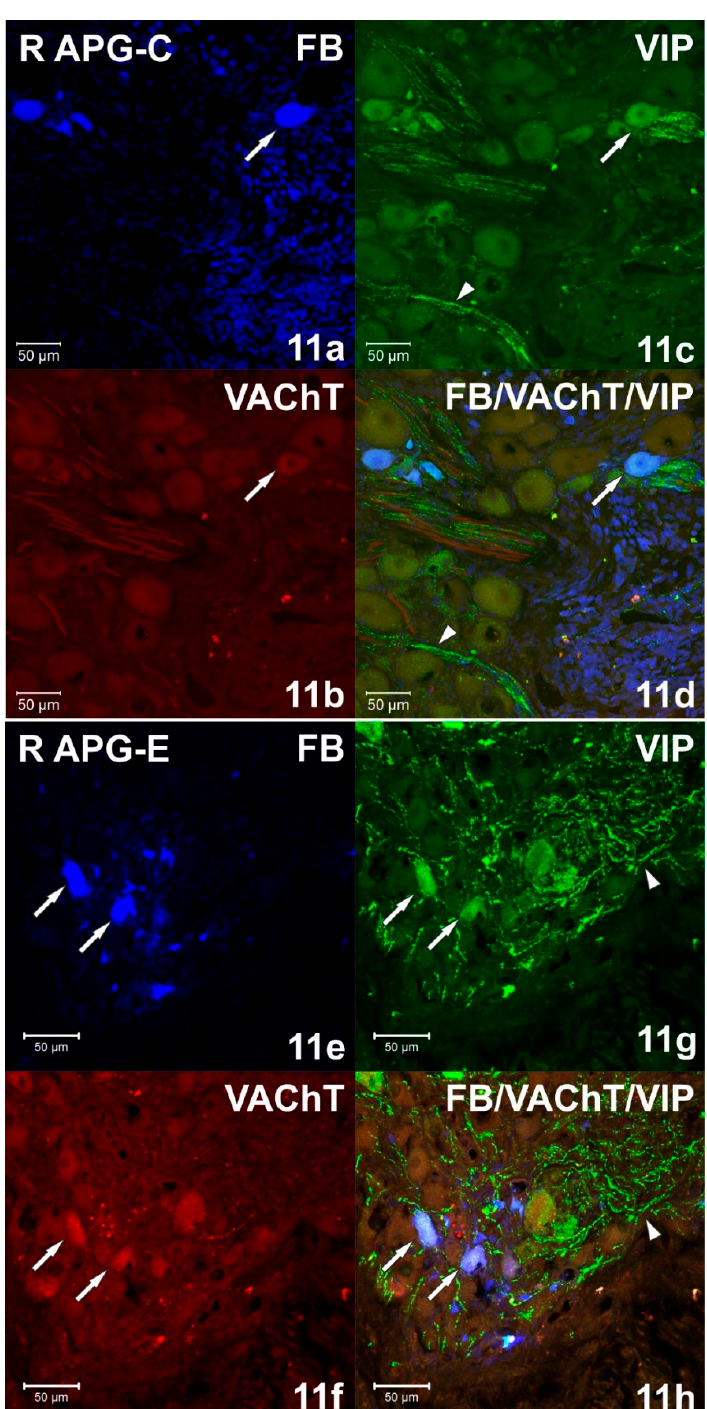
Figure 11. ( a – d ) Confocal laser scanning microscope images showing a section of the right (R) APG from the control (C) group. The arrow indicates the FB+ neuron ( a ) containing VIP ( c ) but VAChT negative ( b ). The arrowhead indicates the low number of VIP-IR fibers ( c , d ). The images were taken from blue, green and red fluorescent channels. Blue, green and red channels were digitally superimposed. Scale bar = 50 µ m. ( e – h ) Confocal laser scanning microscope images showing a section of the right (R) APG from the experimental group. Arrows indicate FB+ neurons ( e ) simultaneously immunoreactive ( h ) against VAChT ( f ) and VIP ( g ). A large number of VIP-IR fibers ( g , h ) were marked with the arrowhead. The images were taken from blue, green and red fluorescent channels. Blue, green and red channels were digitally superimposed. Scale bar = 50 µ